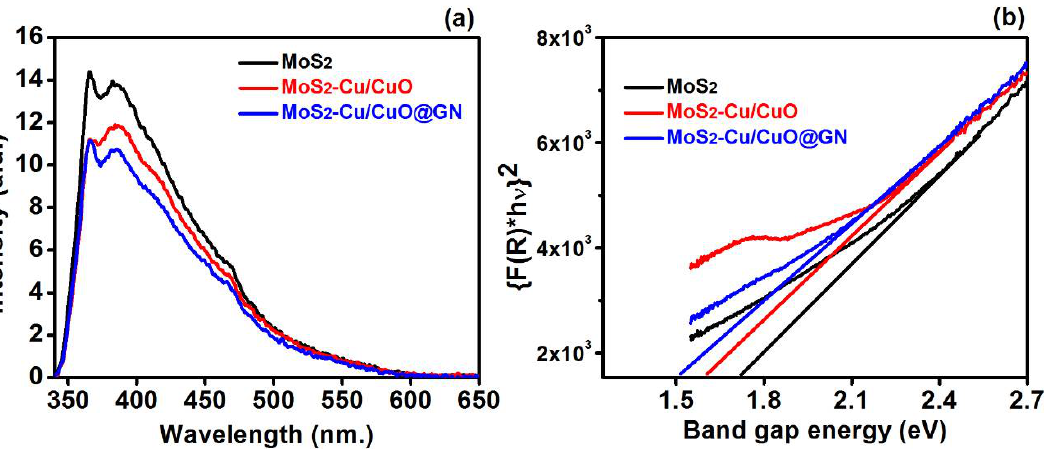
Figure 2. PL analysis ( a ) and band gap calculation ( b ) for MoS 2 , MoS 2 -Cu/CuO and MoS 2 -